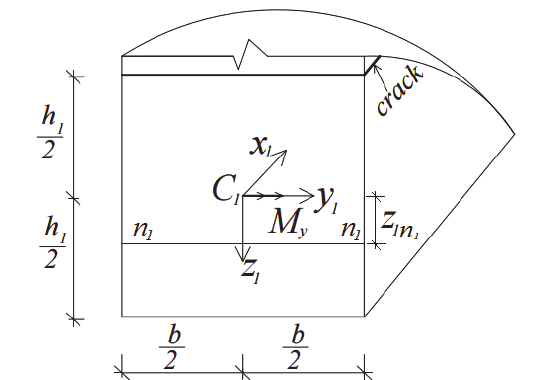
Figure 3: The free end of the lower crack arm (. 1 1 n n  . is the neutral